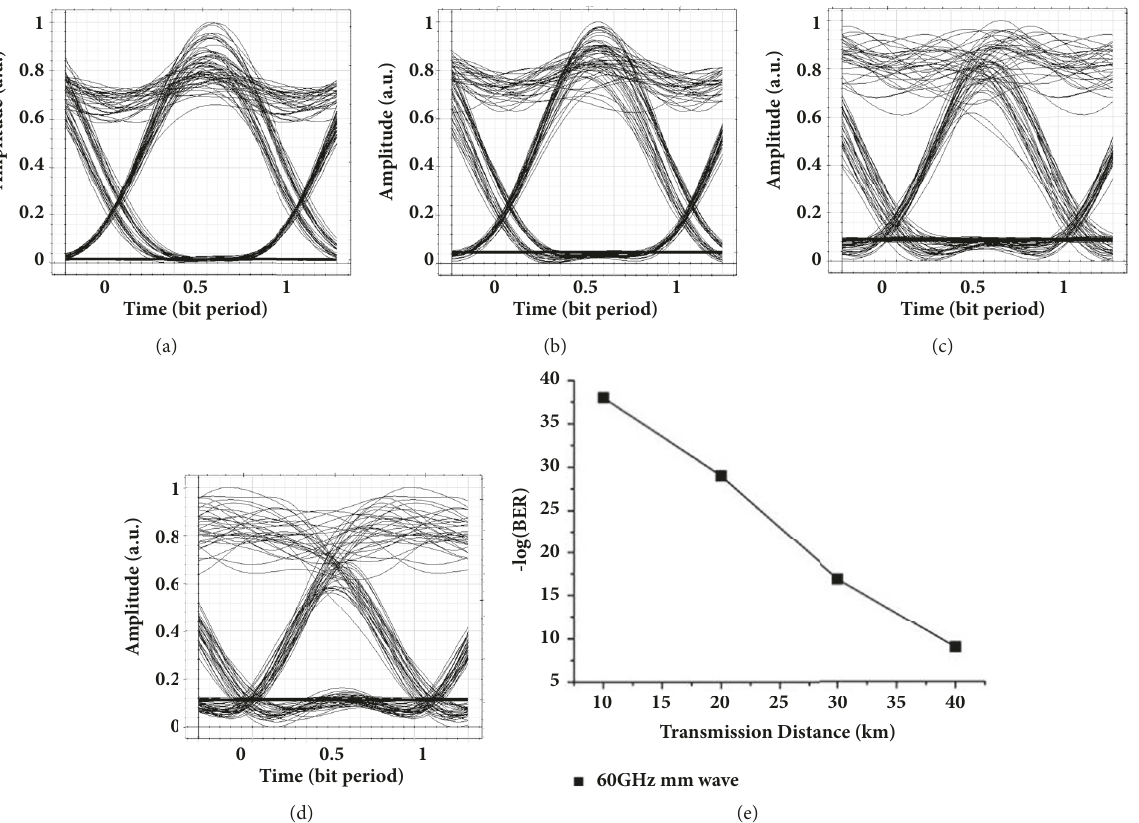
Figure 14: Baseband signal eye diagram of 60GHz mm-wave after fiber transmission over (a) 10 km, (b) 20 km, (c) 30 km, (d) 40 km, and (e) BER versus transmission